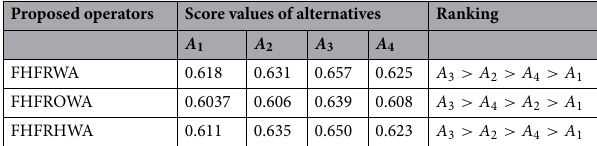
Table 9. Ranking of